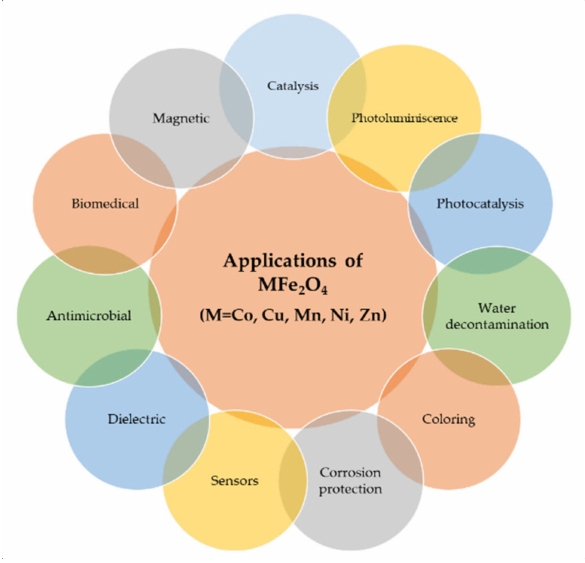
Figure 3. Application of nanosized